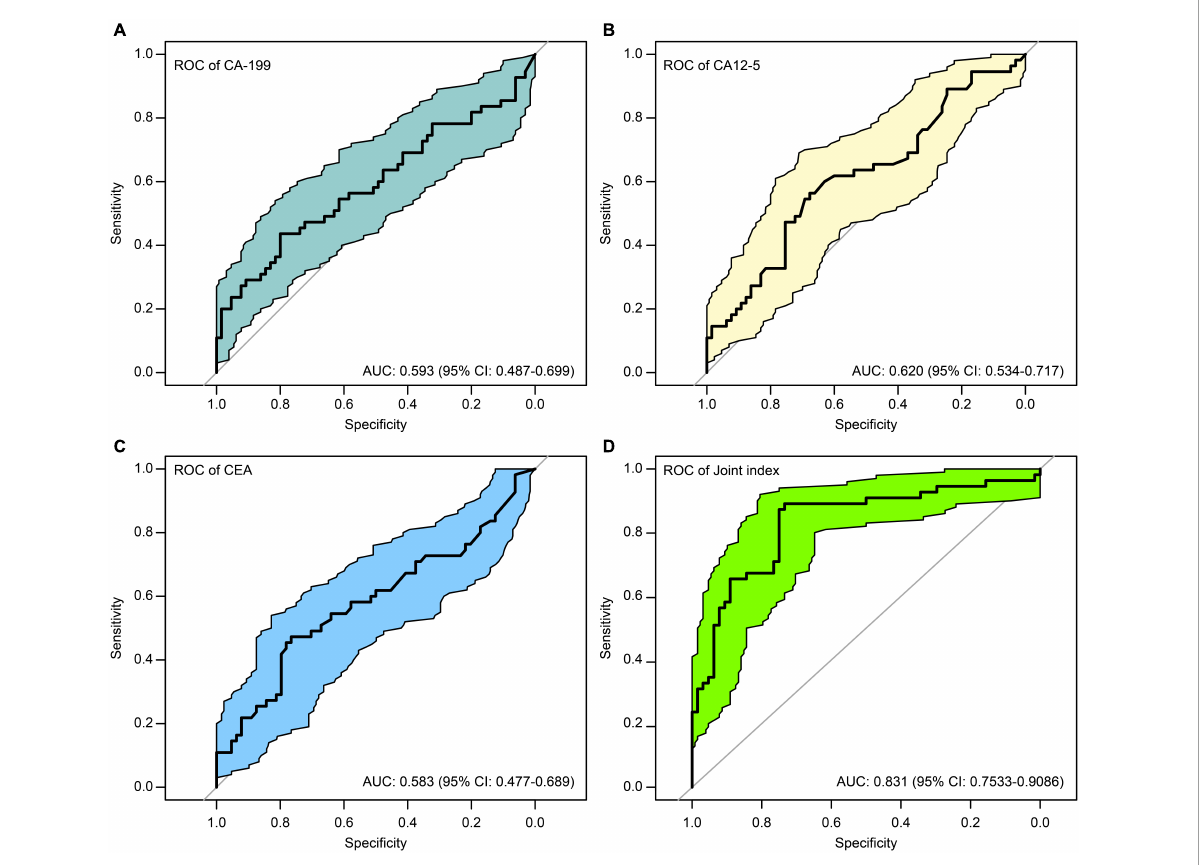
FIGURE4 ROC curves of the of cancer antigen 19-9 (CA19-9) (A) , cancer antigen 125 (CA-125) (B) , carcinoembryonic antigen (CEA) (C) , and the joint index (D) to predict